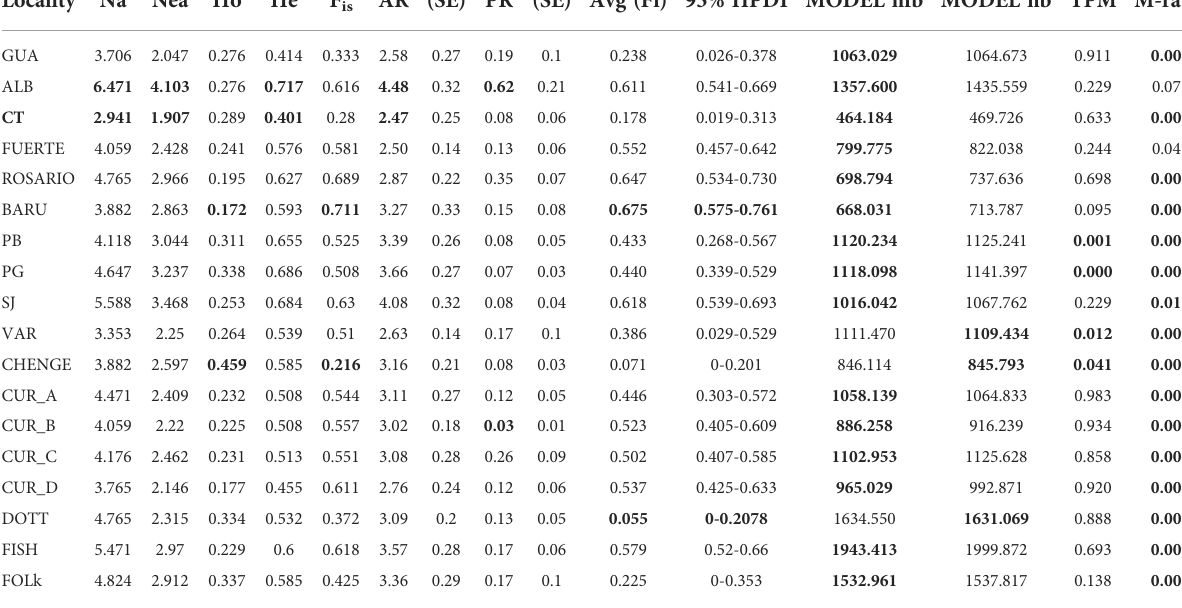
TABLE 1 Genetic diversity for M. auretenra in different localities through the Caribbean. Locality